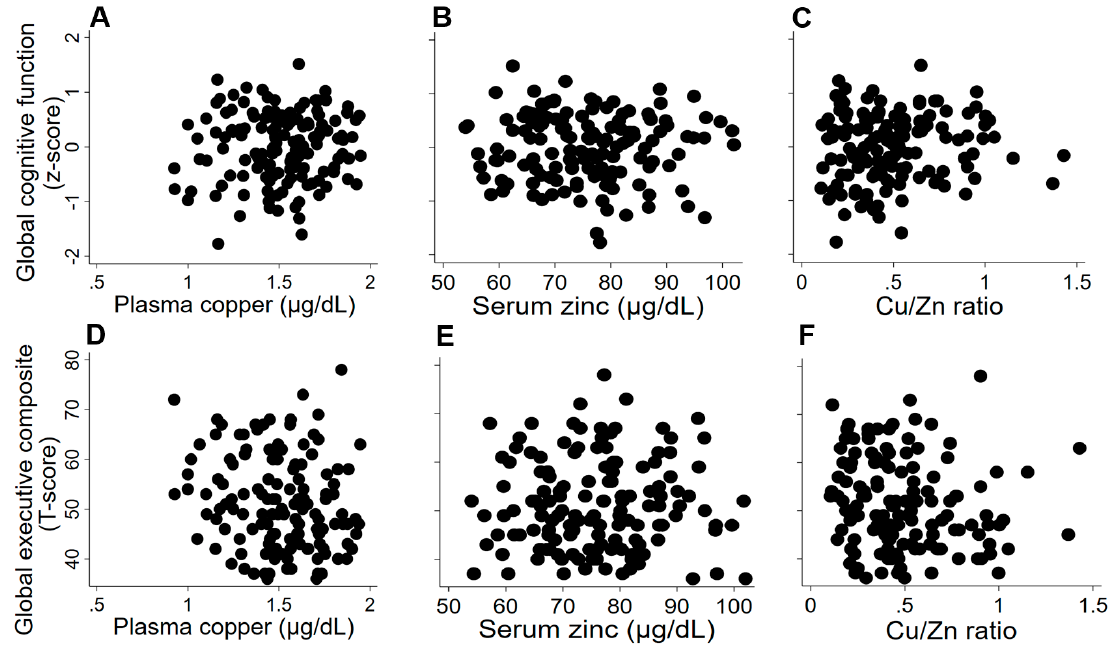
Figure 1. Association between Cogstate global cognitive function ( A )–( C ) and the BRIEF-A global executive composite ( D )–( F ) with copper (log-transformed value) ( A , D ), zinc (adjusted for IL-6) ( B , E ) and Cu / Zn ratio ( C , F ). Results were adjusted for age, sex, BMI, habitual physical activity (kJ weekly spent in vigorous activity), genotypes for APOE (carriers of ε 4 / non-carriers), education (primary school / high school / technical certificate / university), and history of CVD (yes / no).